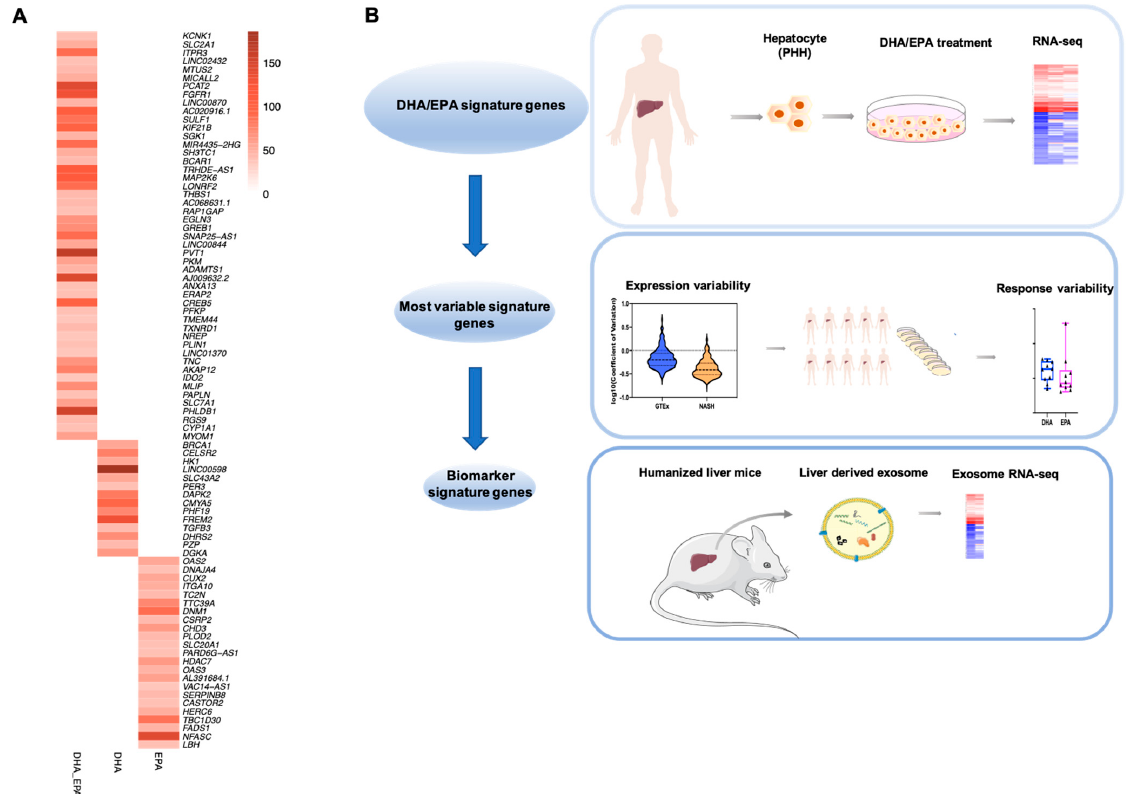
Figure 5. Detection of transcripts for DHA/EPA biomarker genes in liver-derived exosomes in circulation. ( A ) Detection of biomarker signature genes in humanized liver-derived exosomes by intersection of the top 20% human genes with the highest expression level (based on count value) in humanized liver-derived exosome with highly variable signature genes. ( B ) A road map defines biomarker genes representing interindividual variations of hepatic responses to DHA/EPA.